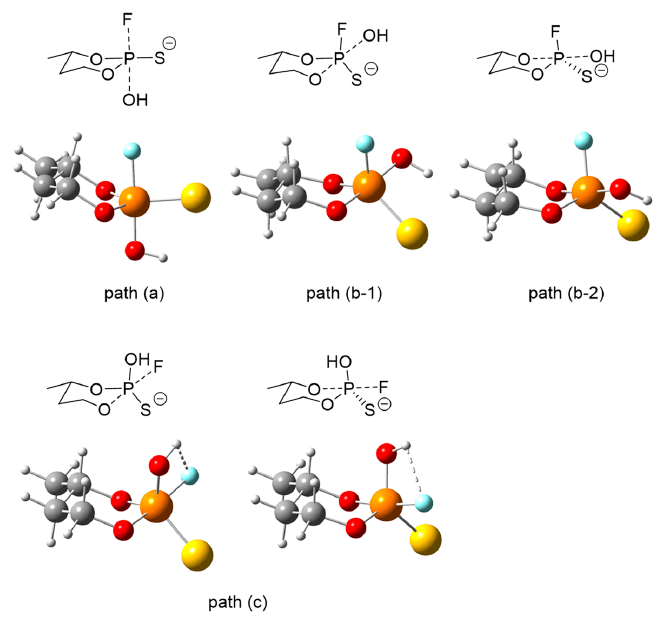
Figure 7. Structures of the P V intermediates resulting from attack of OH − on cis - 6 ( F ); for description of routes a , b and c see Scheme 21.